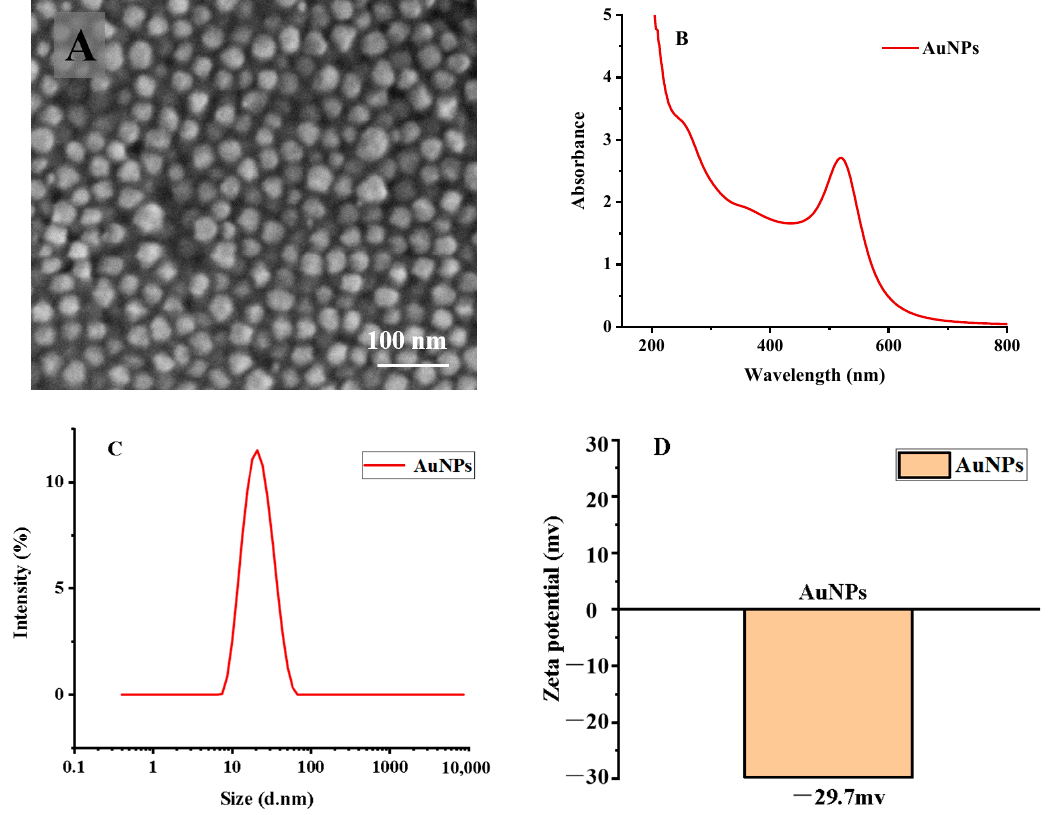
Figure 3. Characterization results of AuNPs. ( A ) SEM image of gold nanoparticles. ( B ) UV-Vis absorption spectra of AuNPs. ( C ) Particle size distribution of AuNPs. ( D ) Zeta potential diagram of AuNPs.